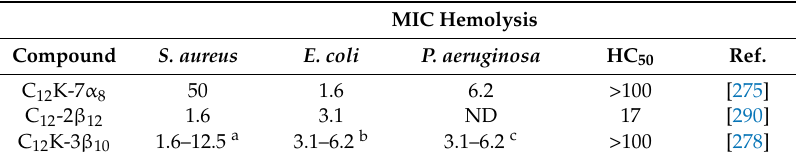
Table 9. Antimicrobial and hemolytic activity of selected OAKs (in µ